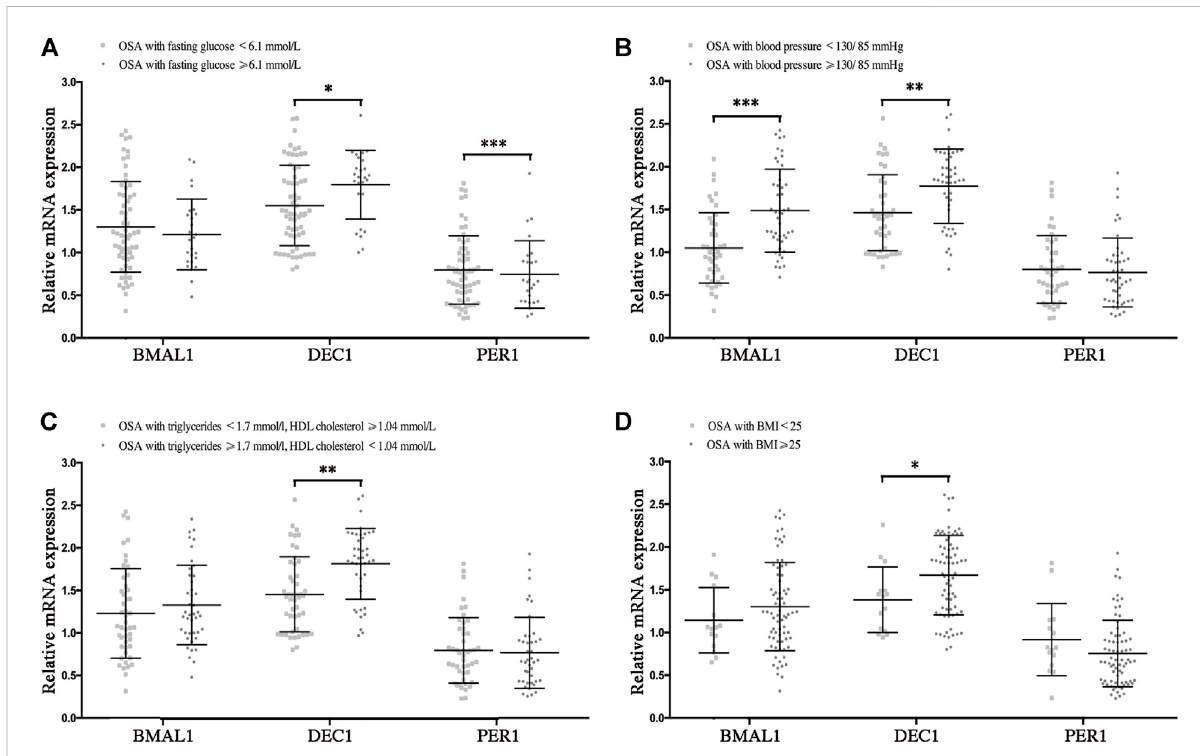
FIGURE 4 Disrupted clock genes are risk factors for the presence of MetS components in OSA. Expression levels of the disrupted clock genes (Bmal1, Dec1, and Per1) in the peripheral blood mononuclear cells from the following indicated OSA subgroups: (A) fasting glucose < 6.1 mmol/L vs. fasting glucose ≥ 6.1 mmol/L; (B) blood pressure < 130/85 mmHg vs. blood pressure ≥ 130/85 mmHg; (C) triglycerides < 1.7 mmol/L and HDL cholesterol ≥ 1.4 mmol/L vs. triglycerides ≥ 1.7 mmol/L or HDL cholesterol < 1.4 mmol/L; (D) BMI < 25, BMI ≥ 25; *, p < 0.05; **, p < 0.01; ***, p < 0.001.